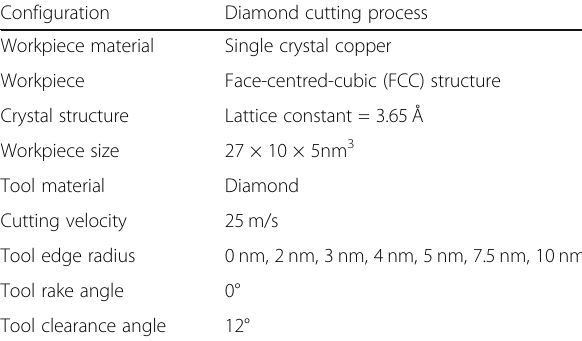
Table 1 Parameters used in the MD simulation